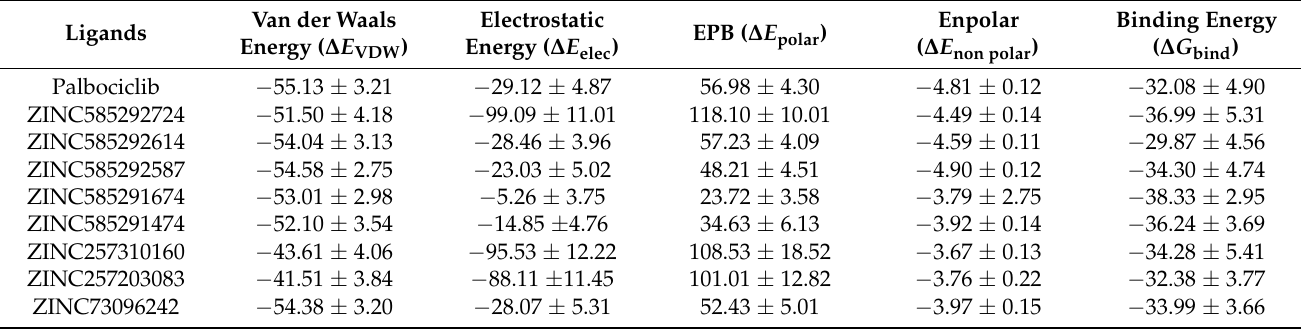
Table 6. The predicted binding free energy and the individual energy components (Kcal/mol) for the ligand − CDK6